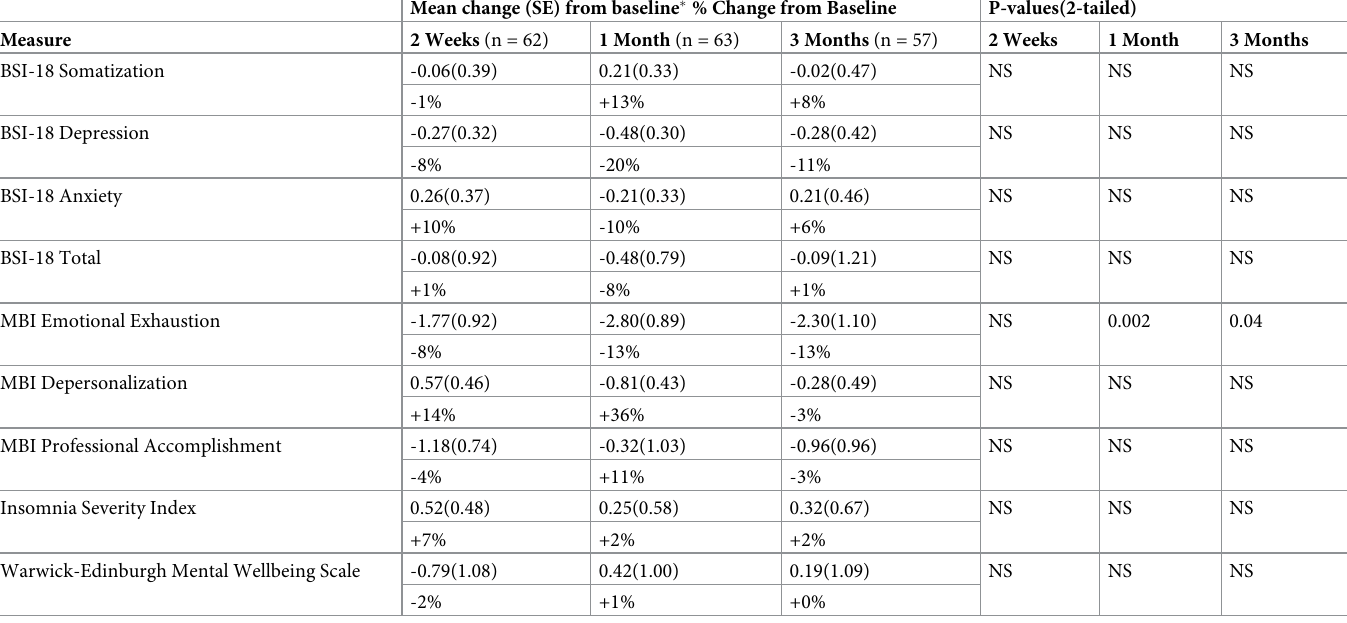
Table 4. Within-group changes for the control